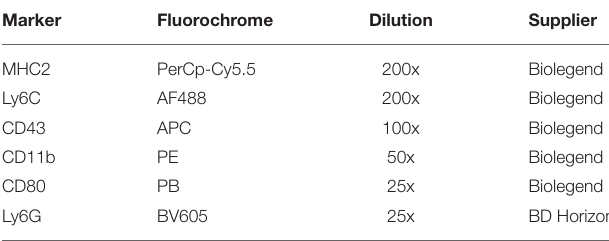
TABLE 2 | Antibody mix for staining of blood monocytes. Marker